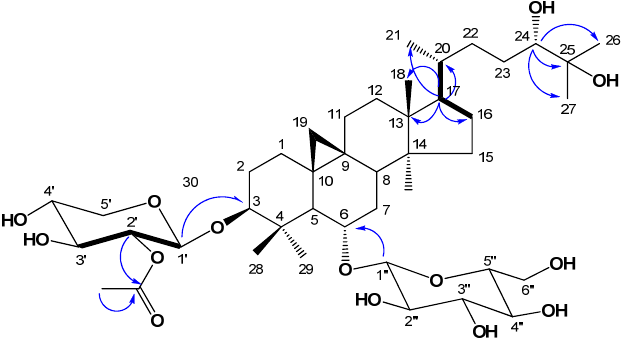
Figure 2. Key 1 H- 1 H COSY (bold dash) and HMBC (blue arrow) correlations of compound 1